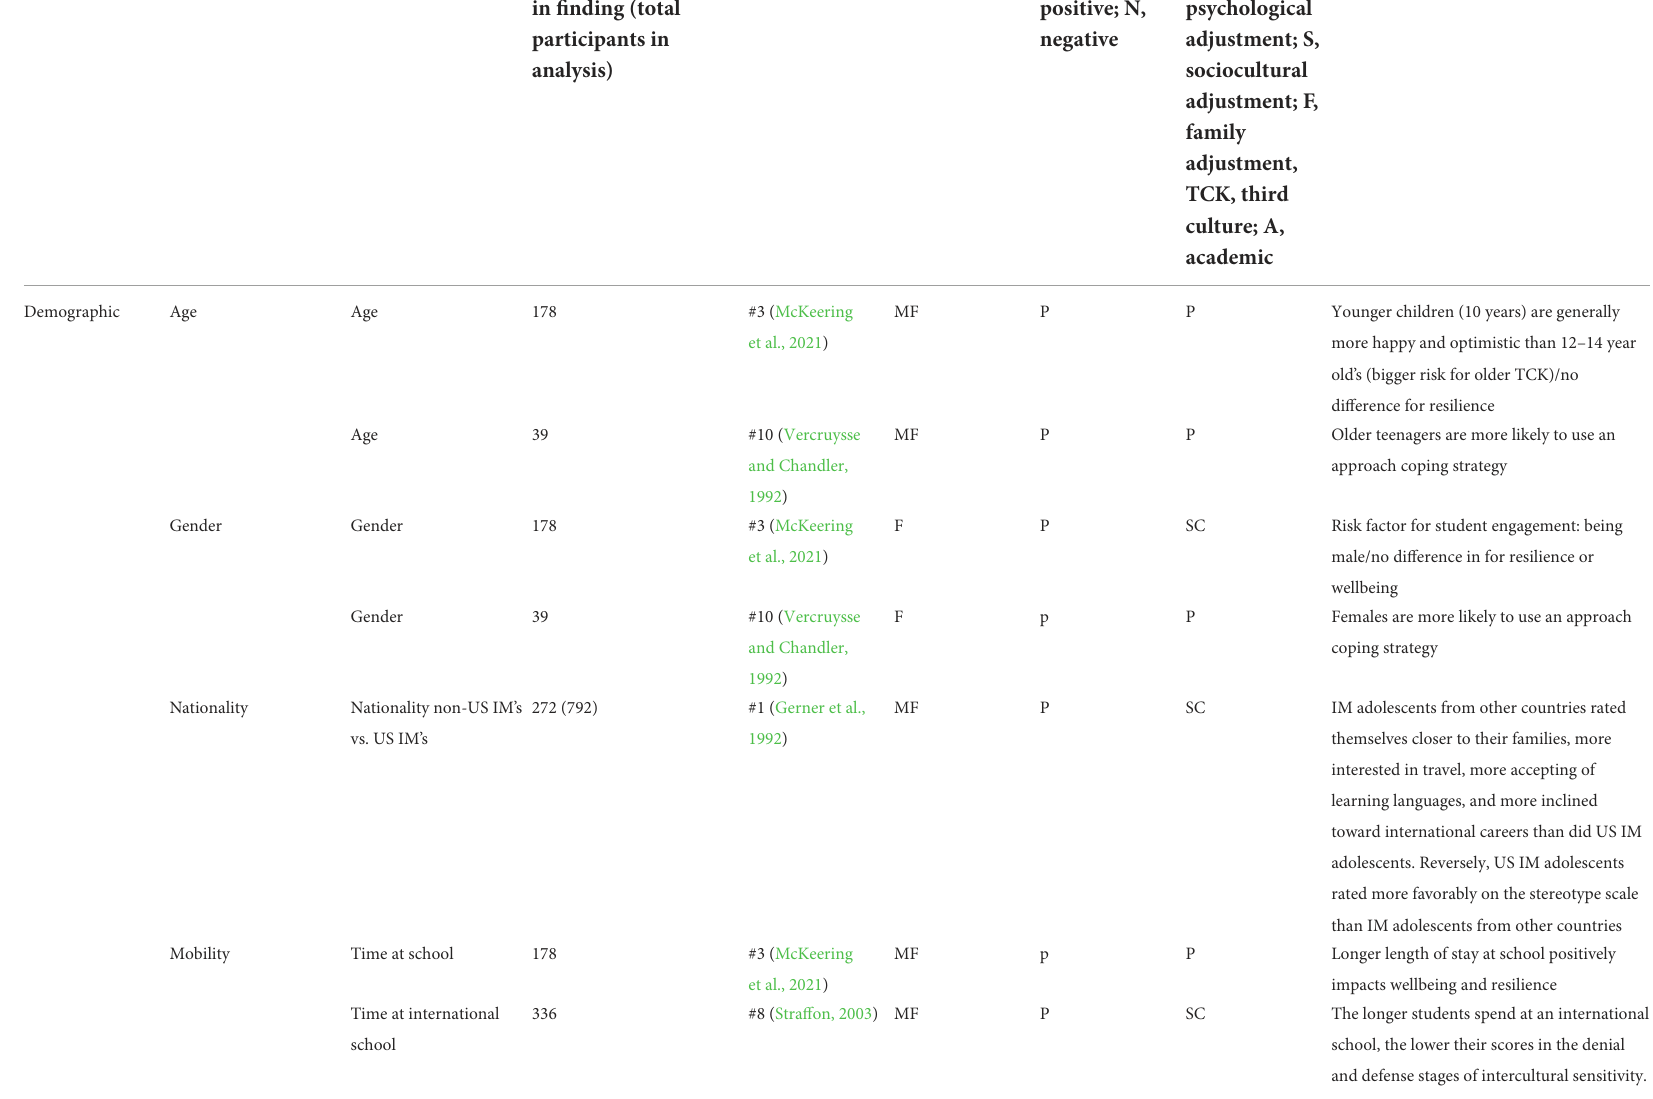
TABLE 4 Abstracted findings from quantitative